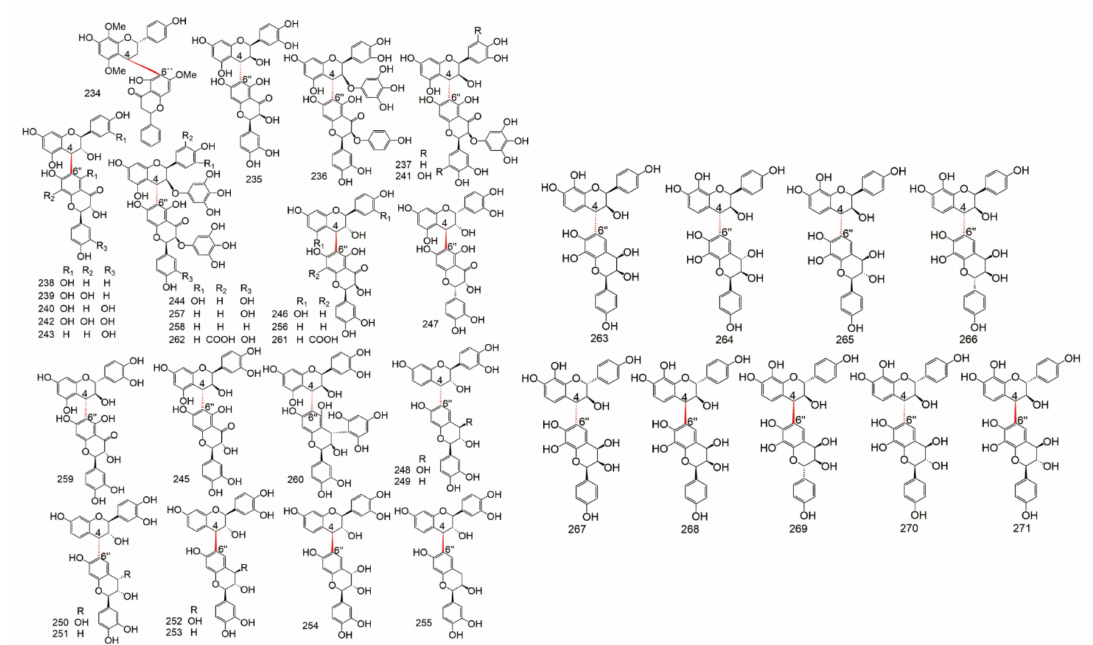
Figure 6. The structure of 4-6 (cid:48)(cid:48) type biflavonoids.